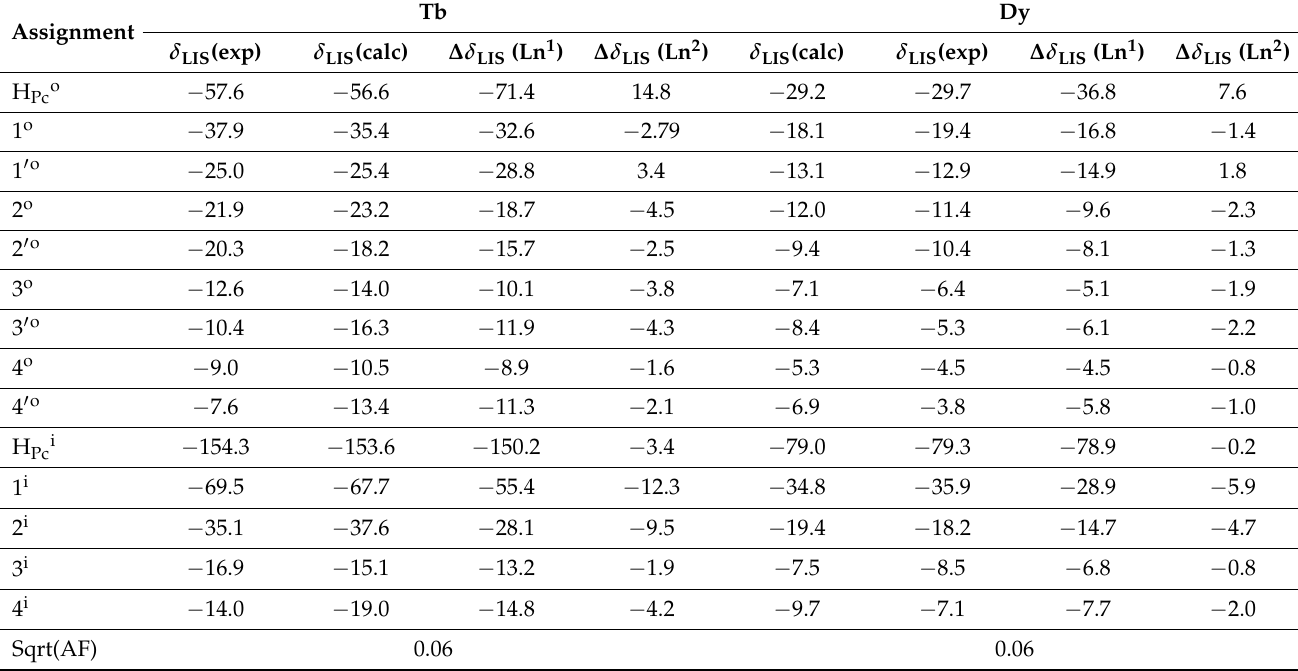
Table 1. The observed δ LIS (exp, ppm) and calculated δ LIS (calc, ppm) pseudo-contact contributions to lanthanide-induced shifts in the 1 H NMR spectra of the Ln 2 [(15C5) 4 Pc] 3 (Ln = Tb and Dy) complexes in CDCl 3 at 303 K.